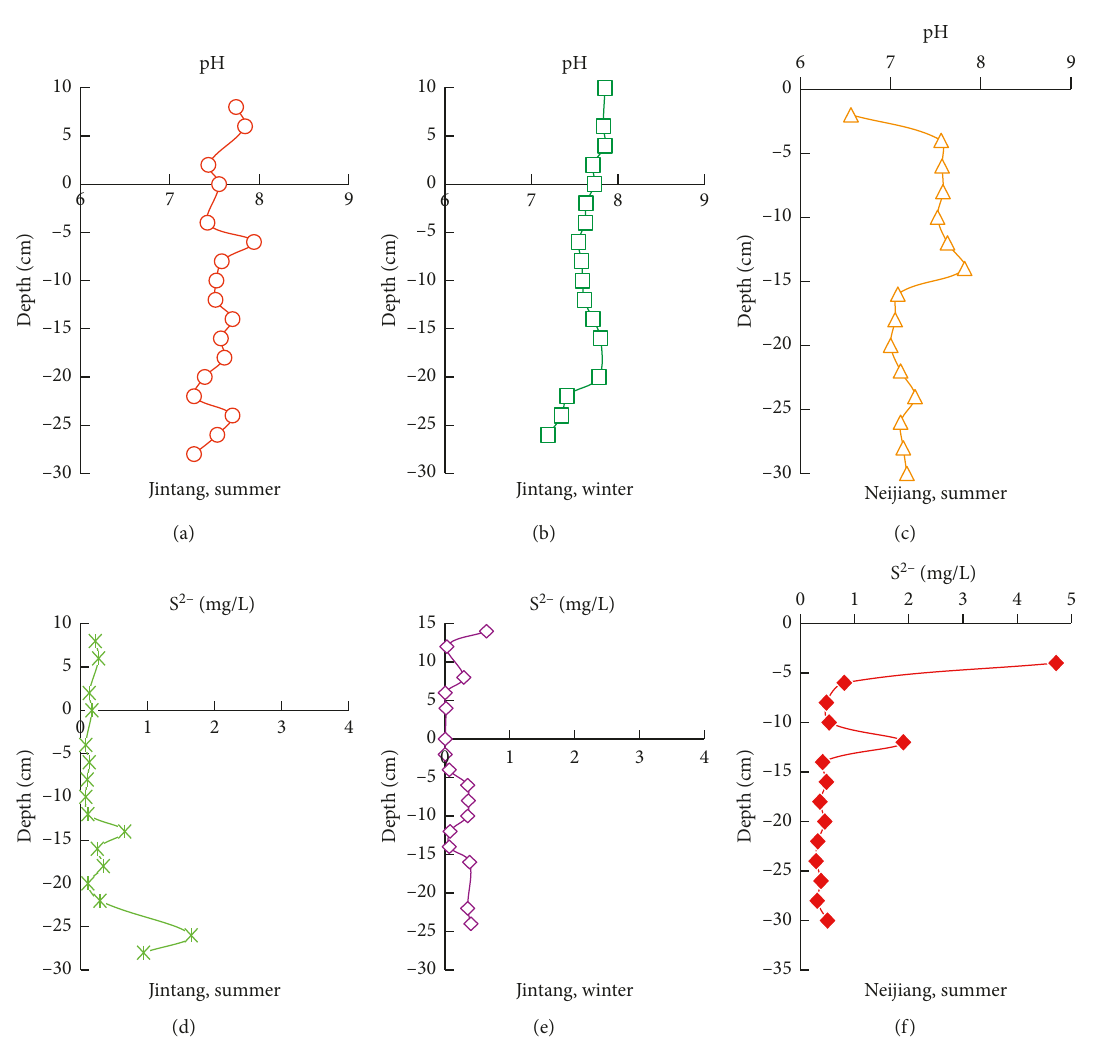
Figure 2: Profiles of pH and dissolved sulfide in pore waters at the two sampling sites, Tuohe River.